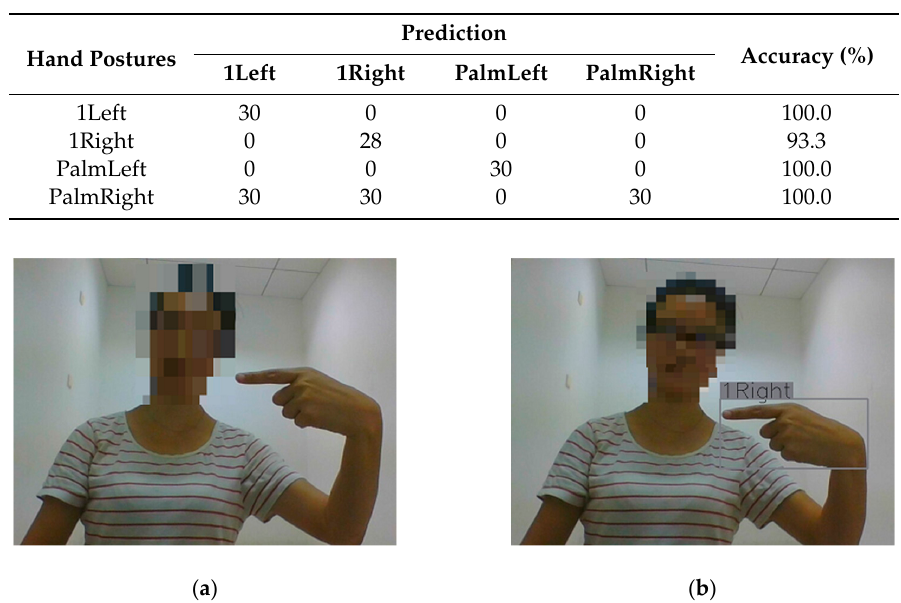
Figure 24. Results of the integration of deictic hand posture and spoken instructions.